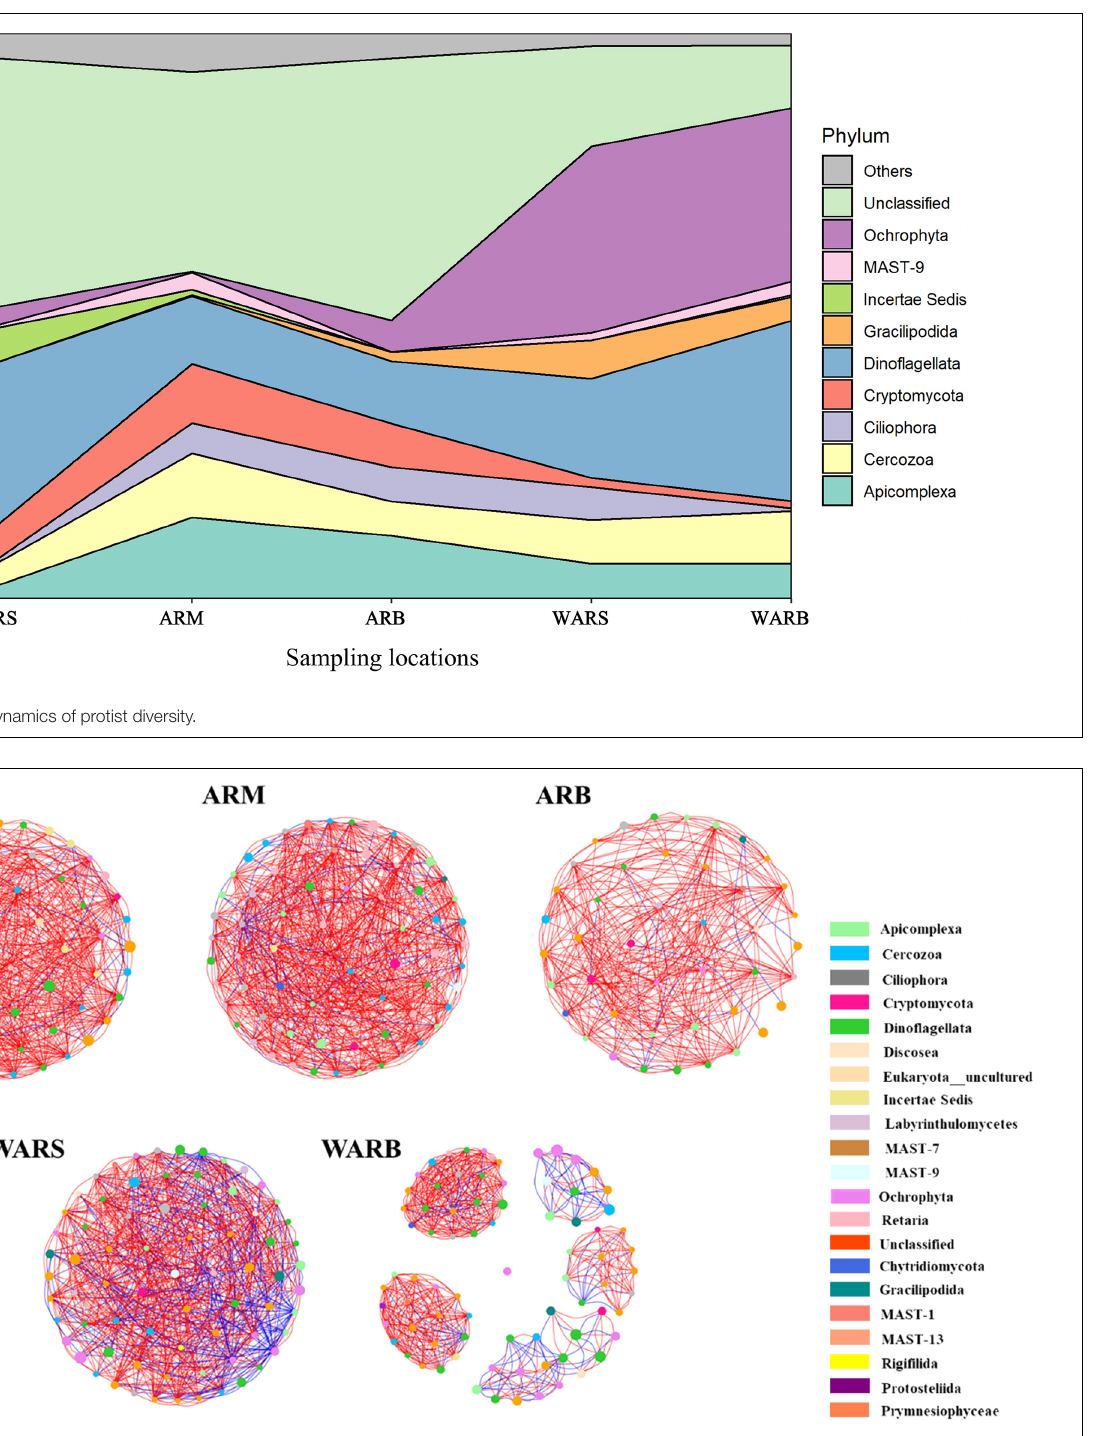
and Unclassified. The shared phyla occupied more than 79% of the nodes in each network, and the proportion increased with an increase in depth. In the horizontal